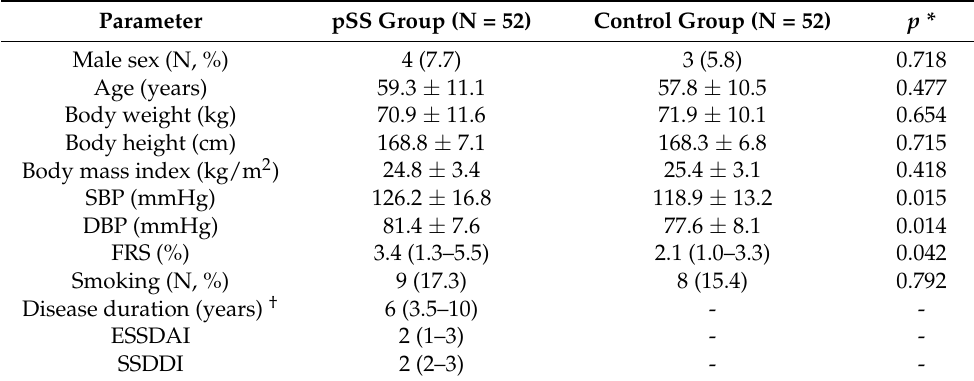
Table 1. Baseline characteristics of pSS patients and healthy controls.